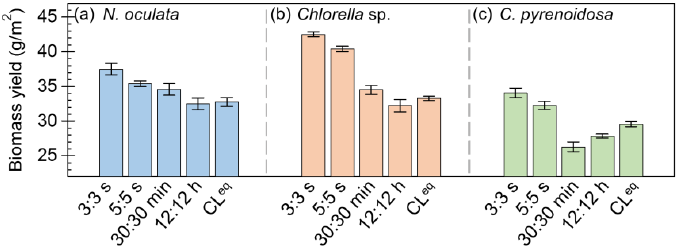
Figure 3. The dry biomass yields of microalgae biofilms cultured under different photoperiods: Nannochloris oculata ( a ), Chlorella sp. ( b ), and Chlorella pyrenoidosa ( c ).